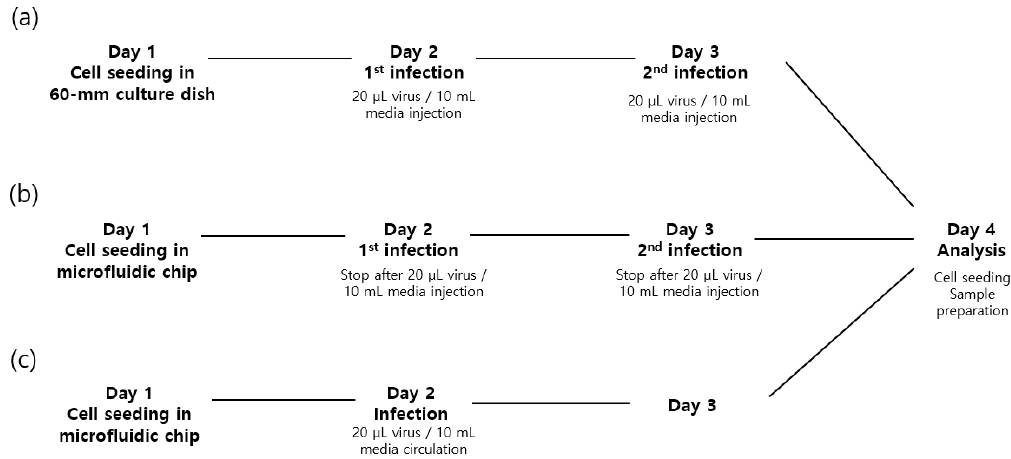
Figure 4. Schematic of experimental protocols of virus infection. ( a ) Conventional static culture (control); ( b ) static condition in the microchannel; ( c ) dynamic cell culture